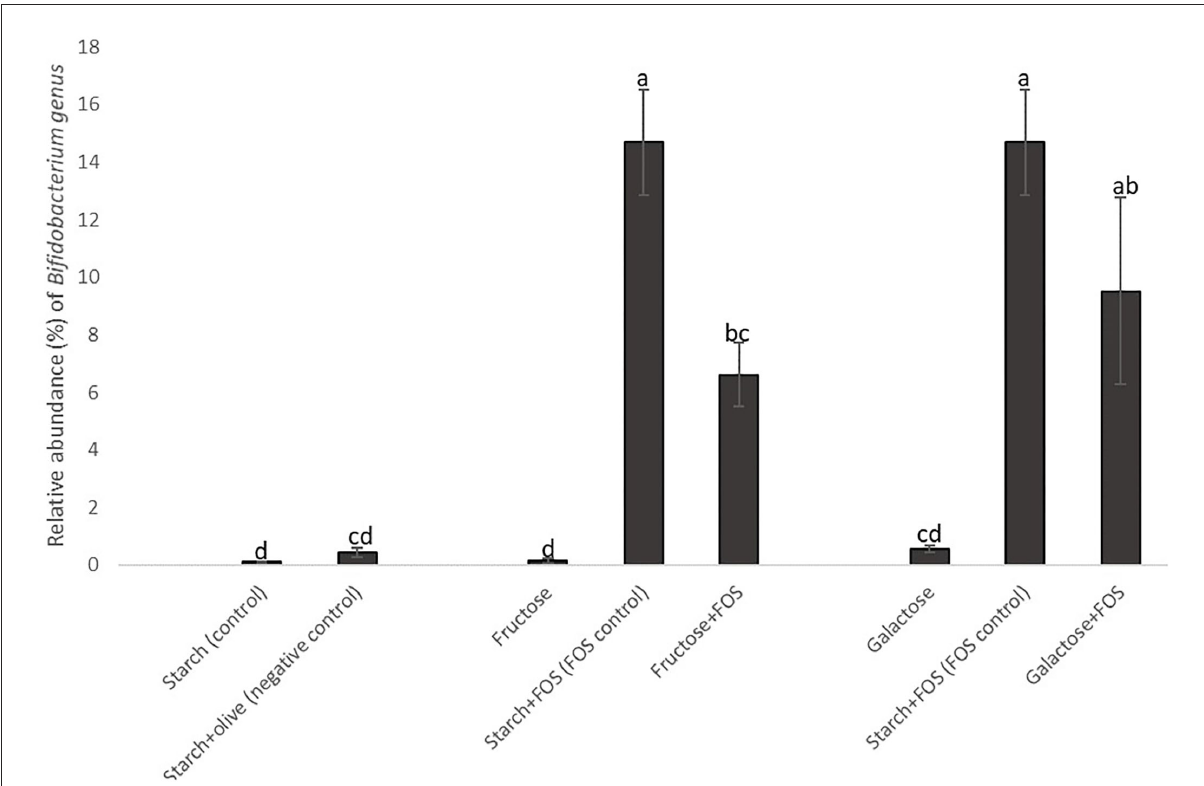
FIGURE4 Changes in the relative abundance of the genus Bifidobacterium in the large intestine of rats fed a control diet (starch, starch + FOS, starch + olive) or a high-fructose or high-galactose diet, with and without added fructooligosaccharides (FOS), after 12 weeks. Values shown are LS mean ± SEM of six rats (percentage of relative abundance). Groups were assessed by one-way ANOVA followed by Tukey’s test. Means with different superscripts (lowercase letters) differ significantly ( p <